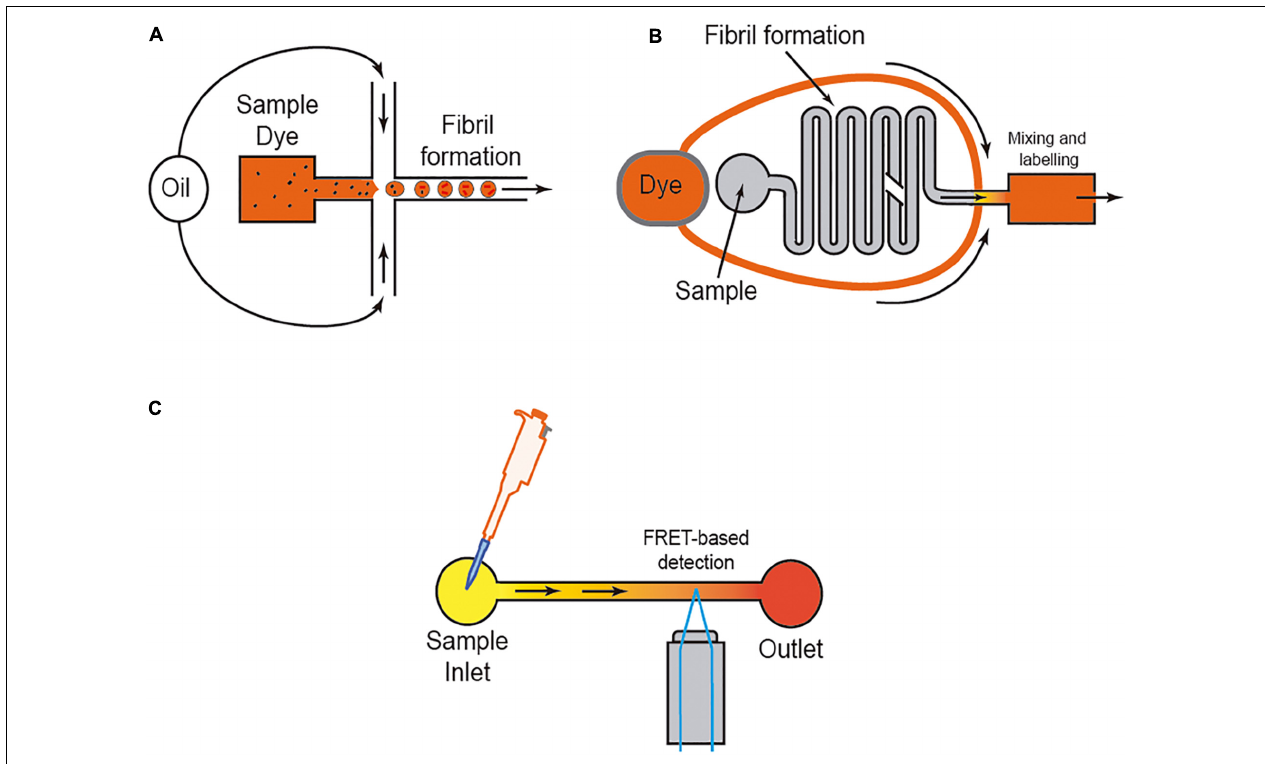
FIGURE 4 | Scheme of three different approaches to analyzing amyloid formation under fluidic flow. In (A) , the micro/nanodroplet formation (water-oil) is illustrated. In (B) a mixing LOC device is illustrated, and in (C) the use of FRET derived protein sensors to monitor protein-protein interaction is illustrated. In each example, the presence of the dye (usually ThT) is